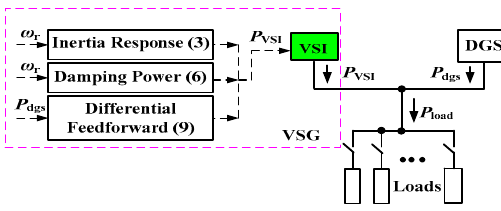
Figure 12. An autonomous microgrid with a DGS and a virtual synchronous generator (VSG) unit. Table 2. Parameters in the simulation and experiment.